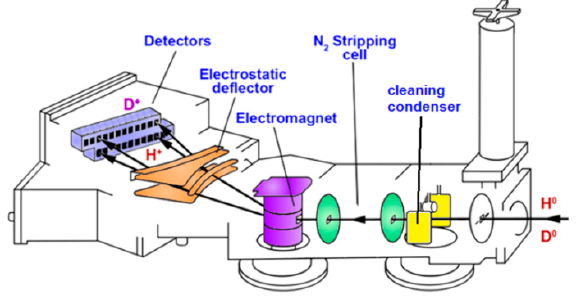
Figure 1. ACORD-type